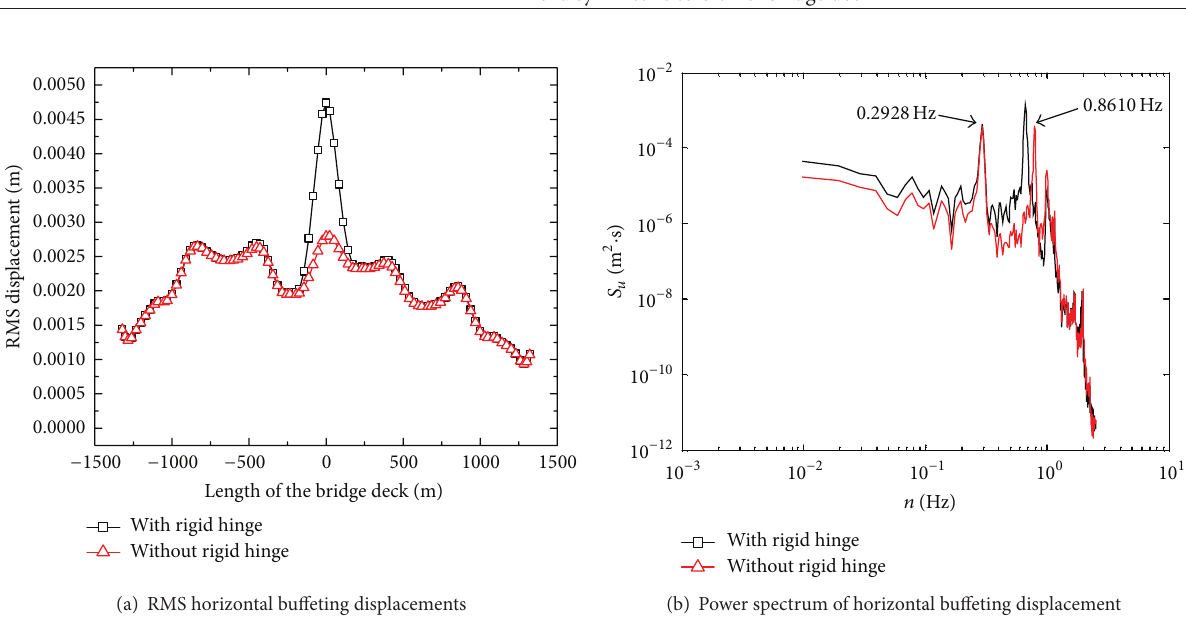
Figure 17: Influence of rigid hinge on the horizontal buffeting displacements of bridge